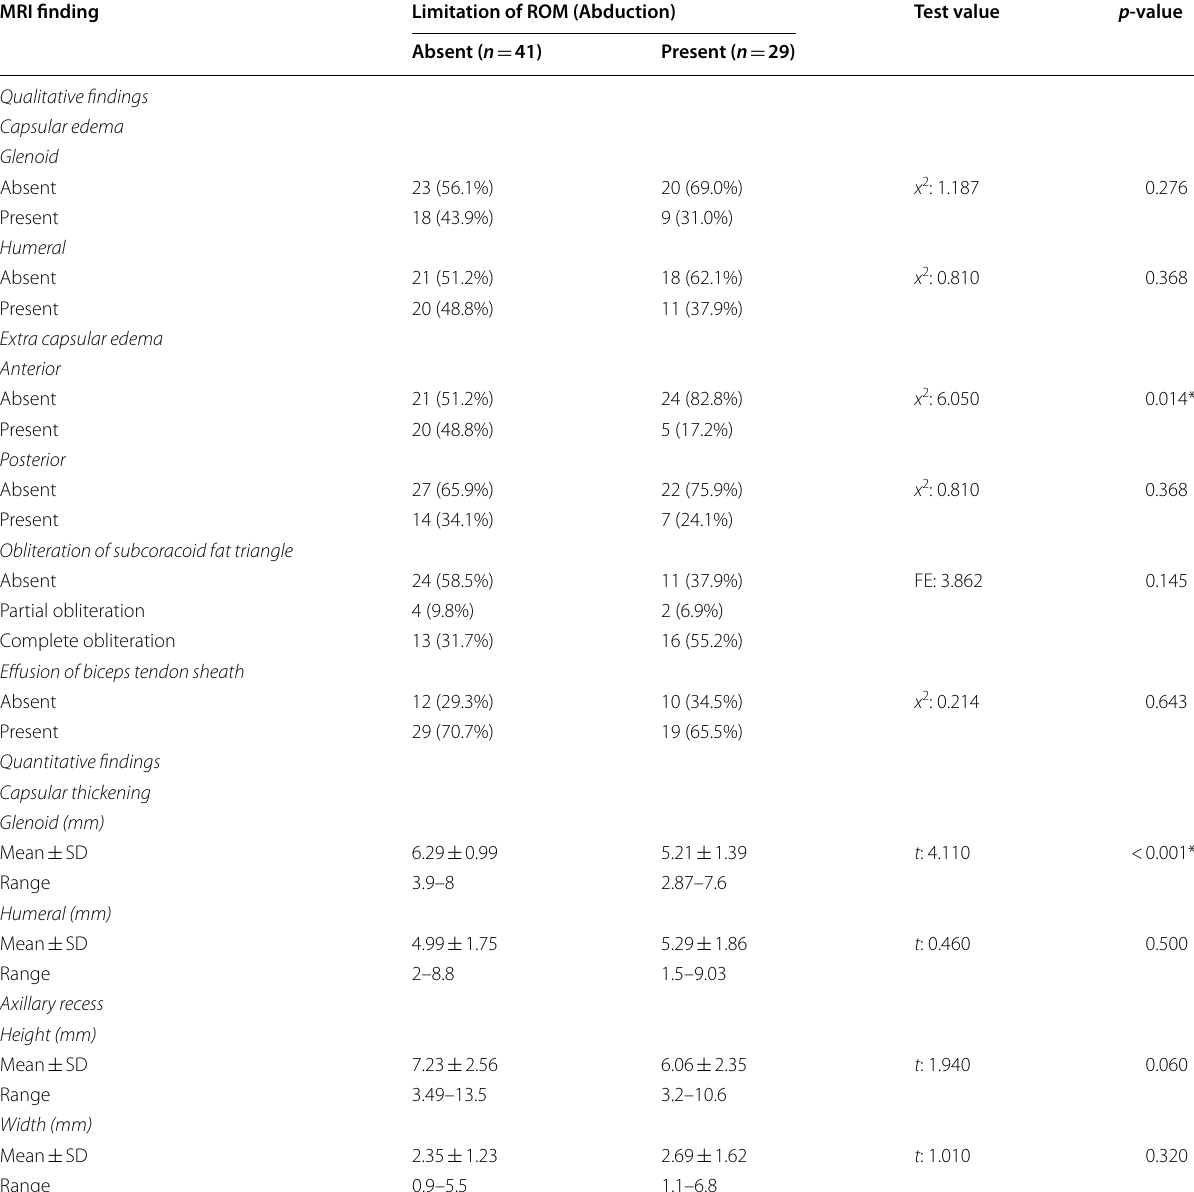
Table 6 Association between limitation of ROM “abduction” according to MRI finding ( n